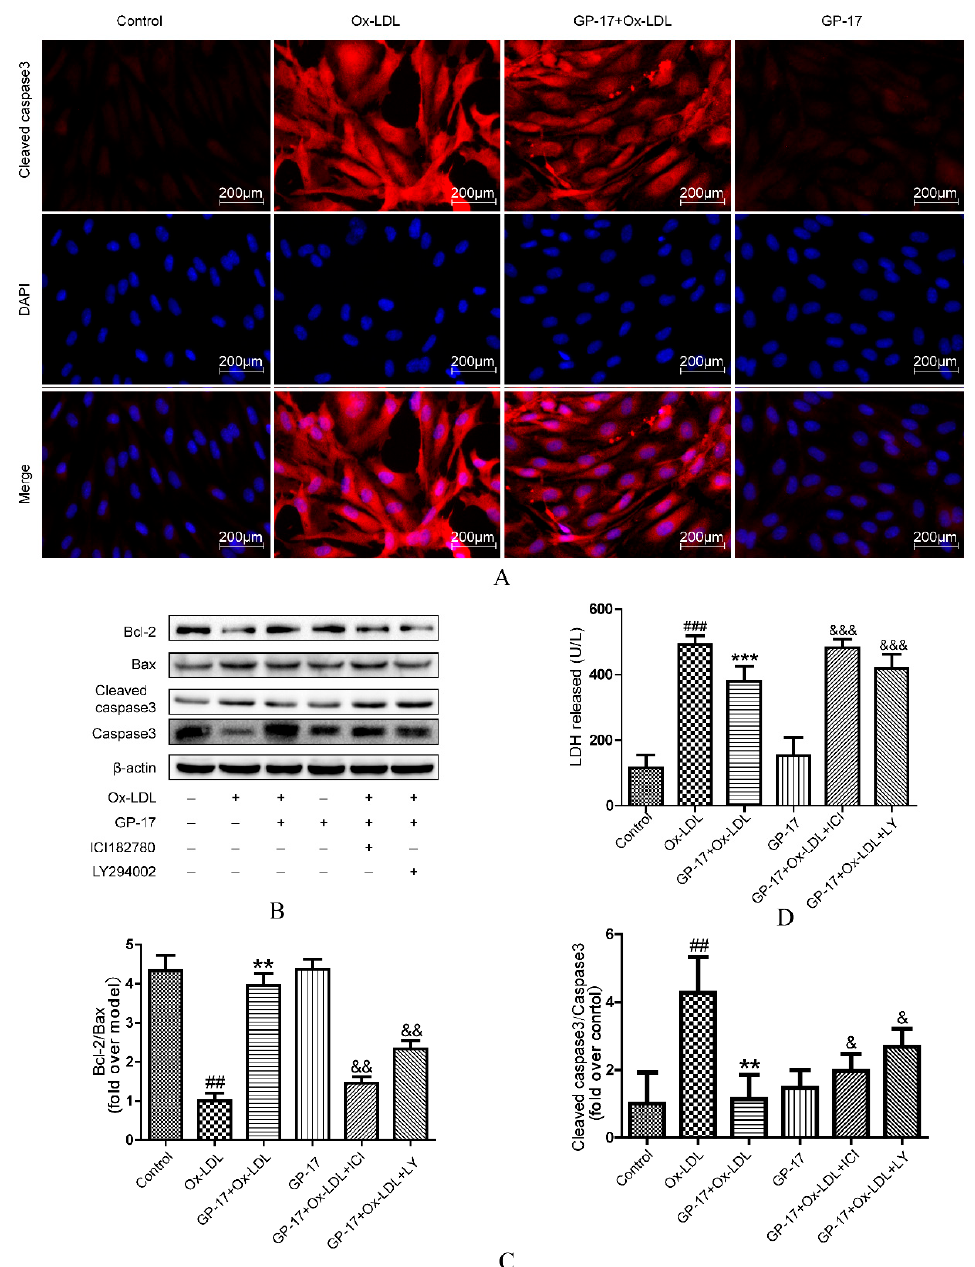
Figure 11. GP-17 protected HUVECs against Ox-LDL-induced apoptosis by decreasing the ratio of Bax to Bcl-2 and controlling cleaved caspase-3 activation. ( A ) The expression of cleaved caspase-3 was analyzed by immunofluorescence assays; ( B , C ) The expression of apoptosis-inducing proteins mediated by GP-17 in Ox-LDL-induced HUVECs was abolished by pretreatment with ICI182780 or LY294002; ( D ) The protective effect of GP-17 against LDH release induced by Ox-LDL in HUVECs. The values are expressed as the mean ± S.E.M. from three independent experiments. ## p < 0.01; ### p < 0.001 vs. Control; ** p < 0.01; *** p < 0.001 vs. Ox-LDL; & p < 0.05; && p < 0.01; &&& p < 0.001 vs. GP-17 + Ox-LDL.